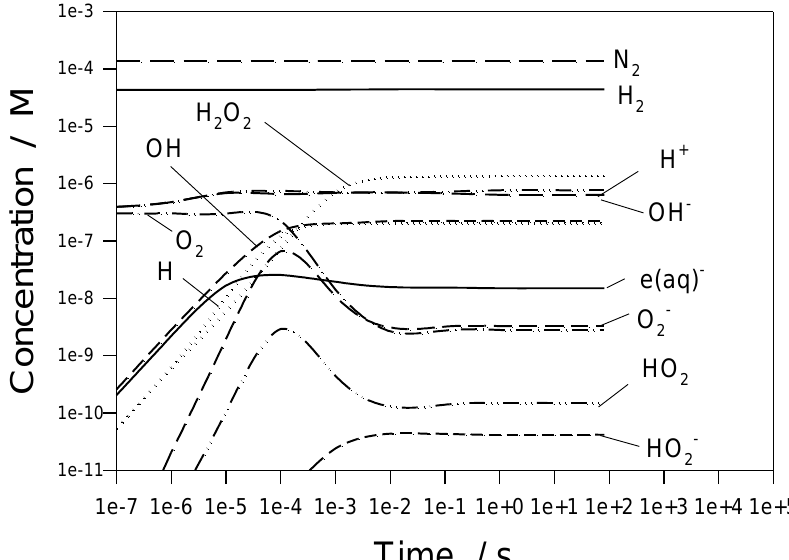
Figure 31. Predicted concentrations of radiolysis species in the single modeled module (see Table 20) as a function of time with addition of 1 cc (STP)/kg H 2 O of hydrogen.